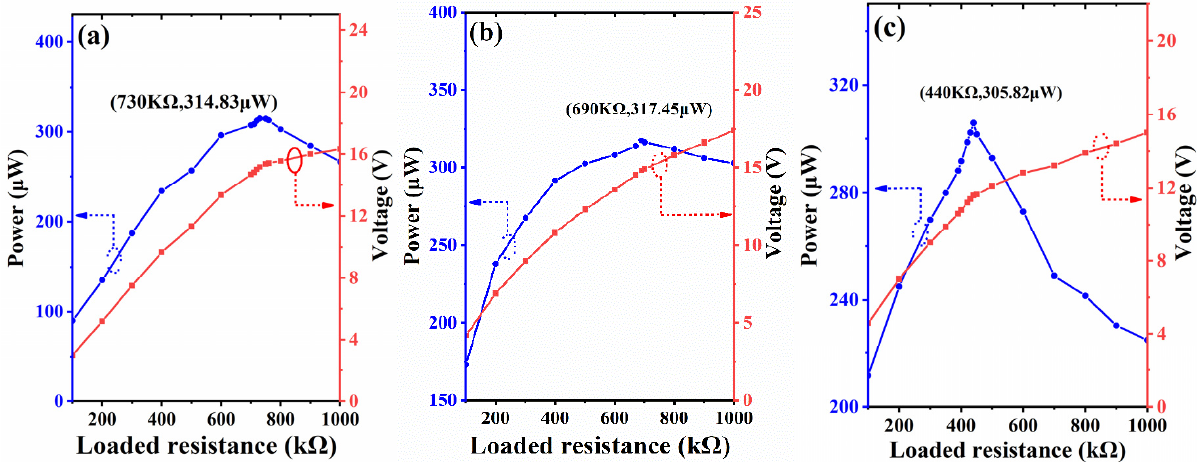
Figure 12. Output power versus loaded resistance under the maximum voltage for ( a ) upper beam, ( b ) lower beam and ( c ) horizontal beam.